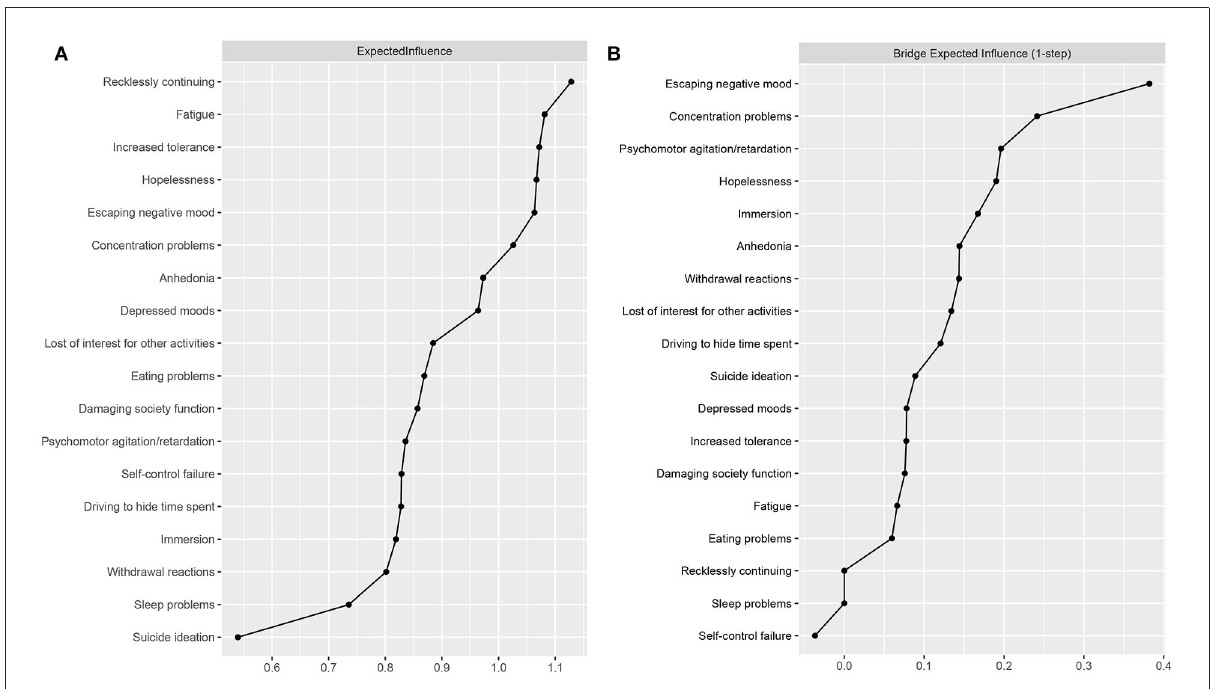
FIGURE2 Centrality plot depicting the (A) expected influence and (B) bridge expected influence of each variable selected in the present